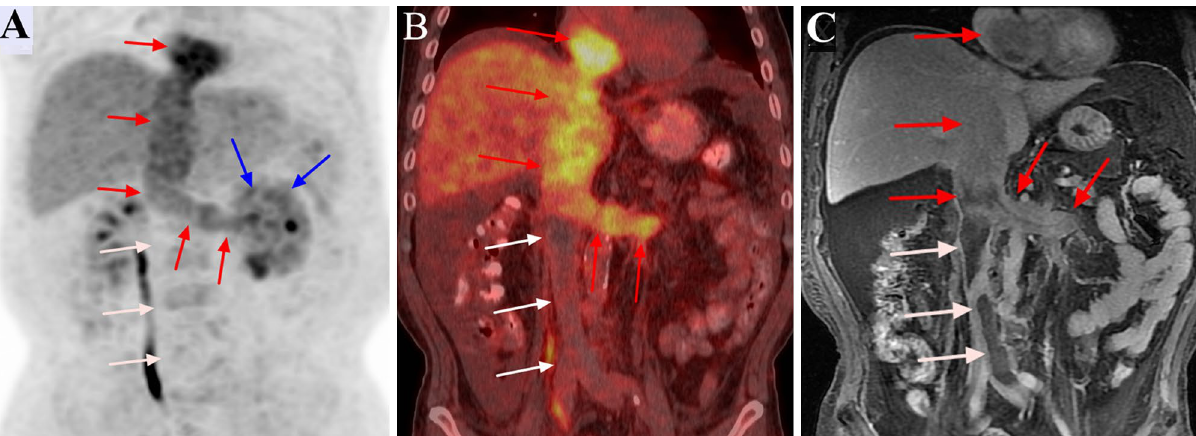
Figure 1. 18 F-FDG positron emission tomography (PET)/computed tomography (CT) and contrast-enhanced MRI (CEMRI) scans of a 67-year-old man who had clear cell carcinoma of the left kidney with a level IV venous tumour thrombus (VTT) and venous bland thrombus (VBT). The VTT had invaded the venous wall and was graded as level IV by both PET/CT and CEMRI. The site of diffusely increased FDG uptake (SUVmax 5.3) on the PET maximum intensity projection image is the primary tumour (blue arrow) ( a ). The site of pathologically increased FDG uptake (SUVmax 5.7) on the PET and PET/CT images from the left renal vein to the inferior vena cava is the VTT (red arrow) ( a , b ). The focal site of decreased FDG uptake (SUVmax 1.2) at the inferior vena cava is the VBT (white arrow) ( a , b ). The VTT with a regular shape shows heterogeneous enhancement and completely occludes the inferior vena cava lumen on coronal CEMRI (red arrow) ( c ), while the VBT shows no enhancement (white arrow) ( c